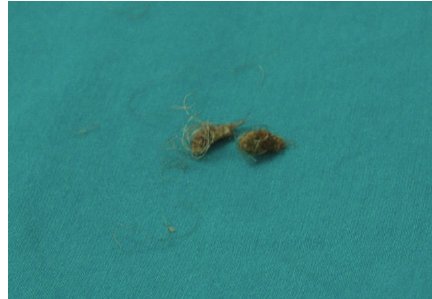
Figure 1: Case 1: Inspection revealing protrusion in the ventral side of the penile shaft.